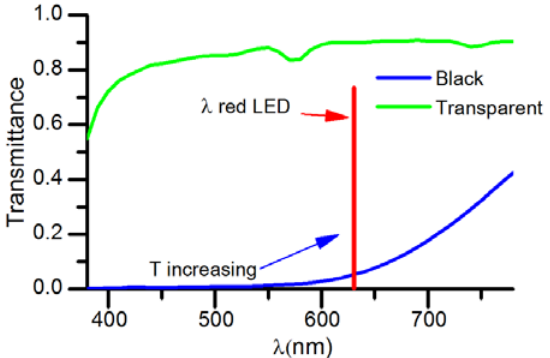
Figure 1. Optical transmittance of black and transparent ceramic glass (Schott CERAN HightransEco and Cleartrans).